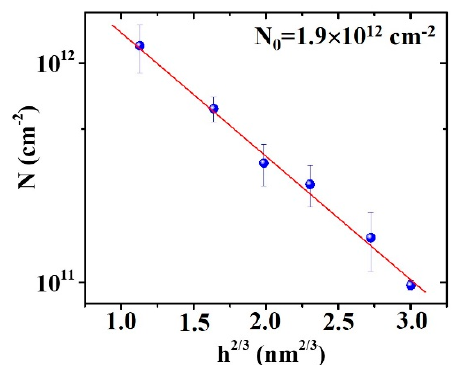
Figure 7. Plot of mean number of Au/Pd islands (LogN) versus h 2/3 with h being the thickness of the deposited Au/Pd film (with 1.2 ≤ h ≤ 5.2 nm). Full line arose by the fitting procedure of the experiment data.